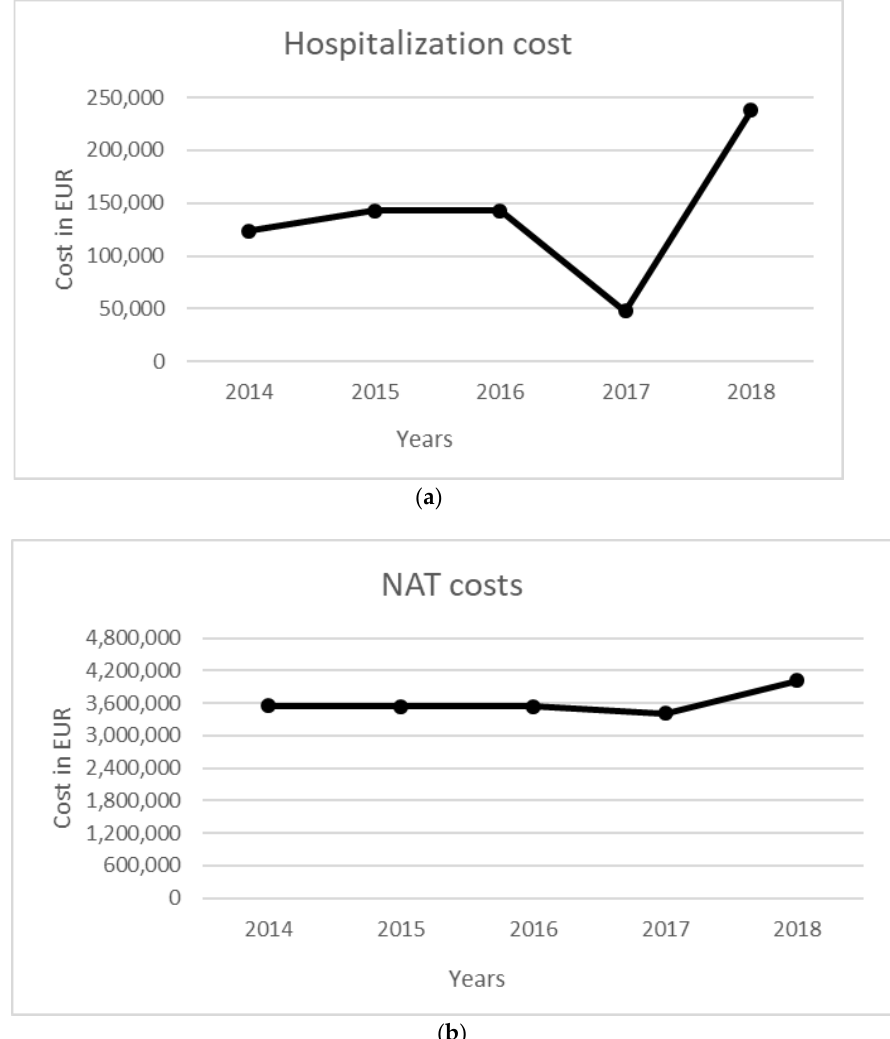
Figure 1. Annual costs per environmental/veterinary surveillance. ( a ) Entomological, ( b ) ornitho- logical, and ( c ) equine surveillance.